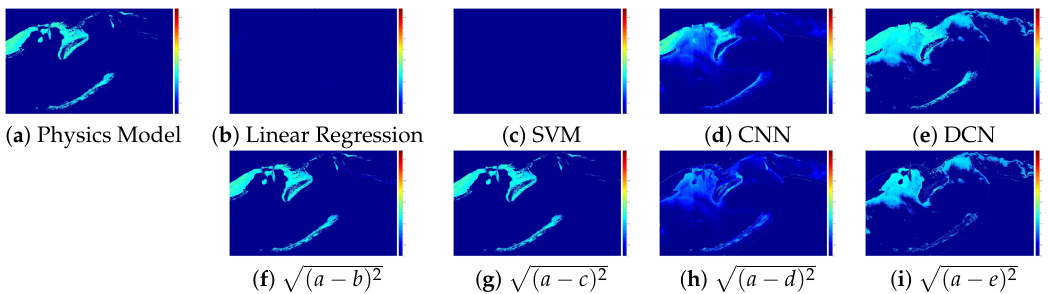
Figure 11. LAI mapping at Keeton Beach produced by our transfer learning approach using 500 patches.